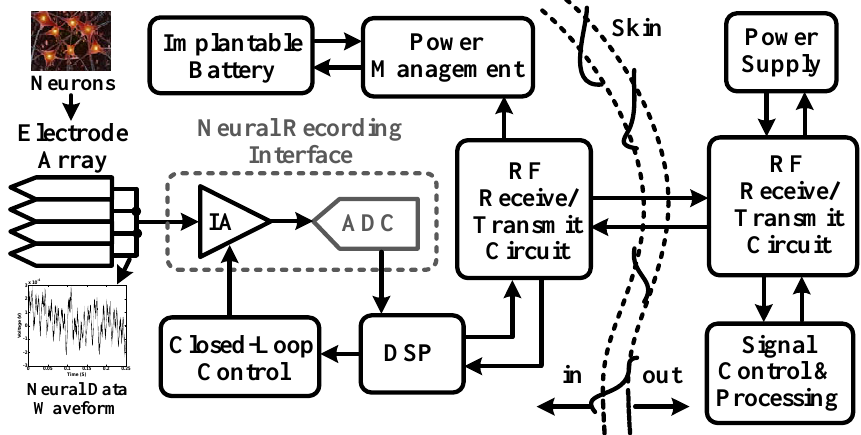
Figure 1. Block diagram of a wireless neural recording